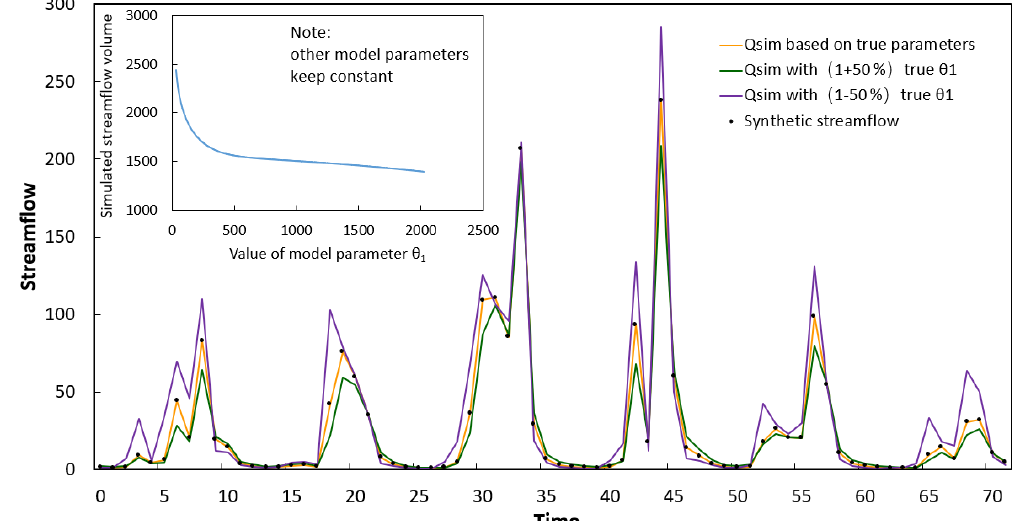
Figure 2. Example of the impacts on model simulation due to the different shifts in model parameter θ 1 (that denotes the catchment water storage capacity). Qsim refers to the simulated